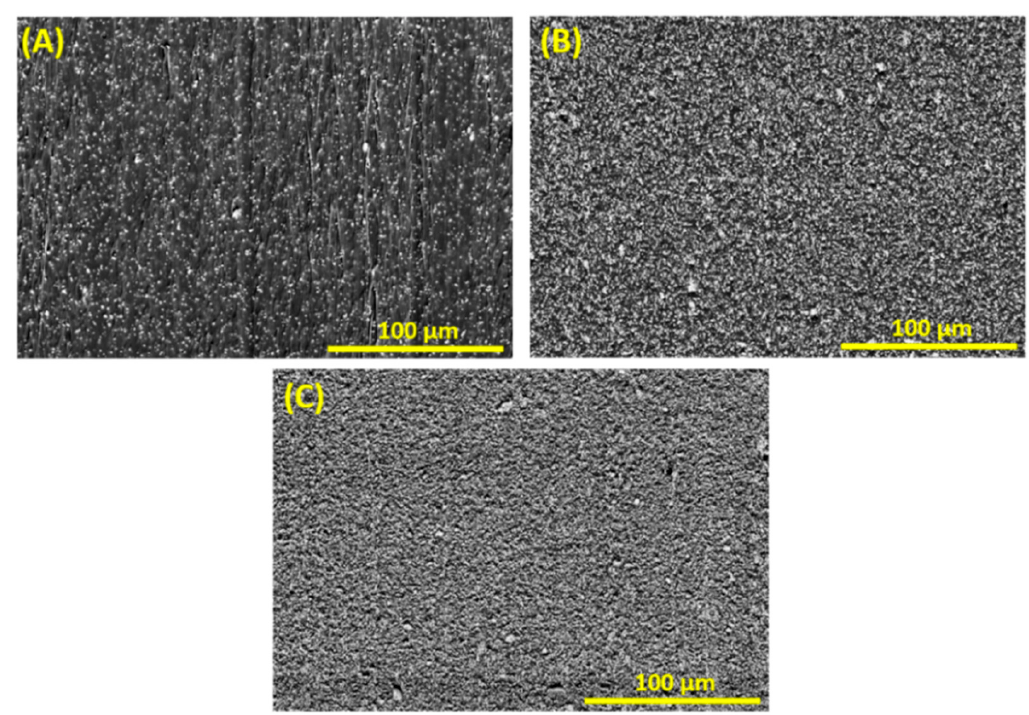
Figure 4. The 0–3 unstructured EVA/BaTiO 3 composites with different volume fractions: ( A ) 3 vol%, ( B ) 16 vol%, ( C ) 29 vol%.